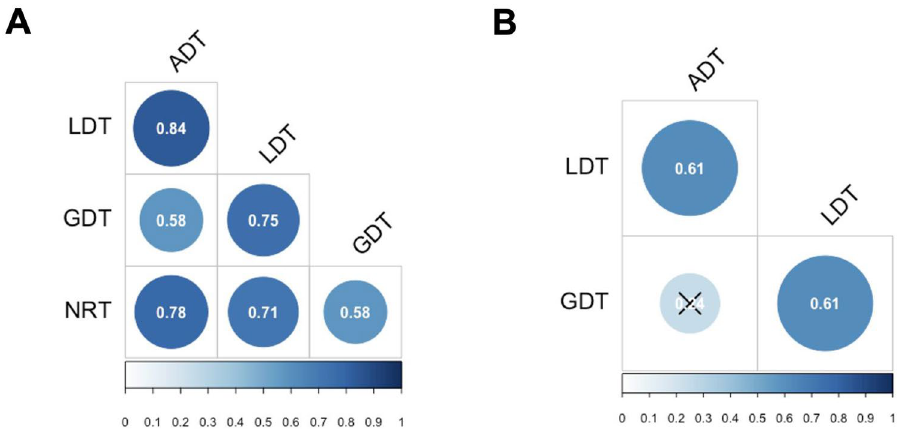
Figure 2. ( A ) Pairwise Pearson correlations of standardized mean RTs for correct responses by participant in each task. ( B ) Partial Pearson correlation of standardized mean RTs for correct responses by participant between ADT, LDT, and GDT while controlling for NRT (the partial correlation between GDT and ADT, marked by a cross, was not significant: p =